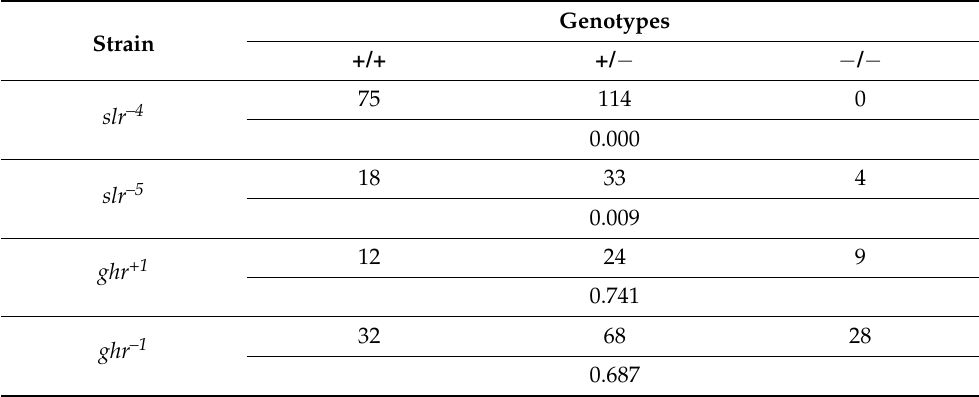
Table 4. Viability of slr − 4 , slr − 5 , ghr +1 , and ghr − 1 among the genotypes of F 2 adult fish.